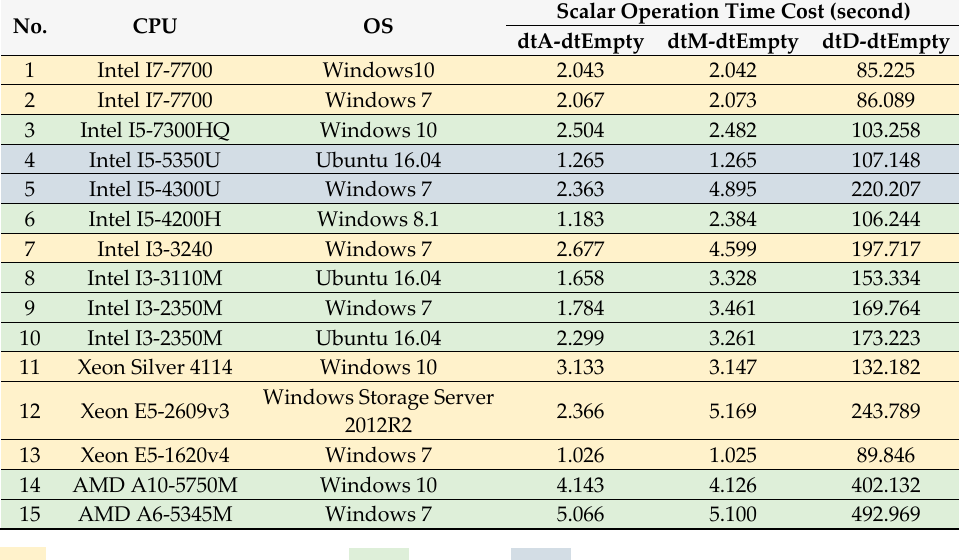
Table 7. Tests of scalar operation time cost with different hardware platforms. CPU, central processing unit; OS, operating system.